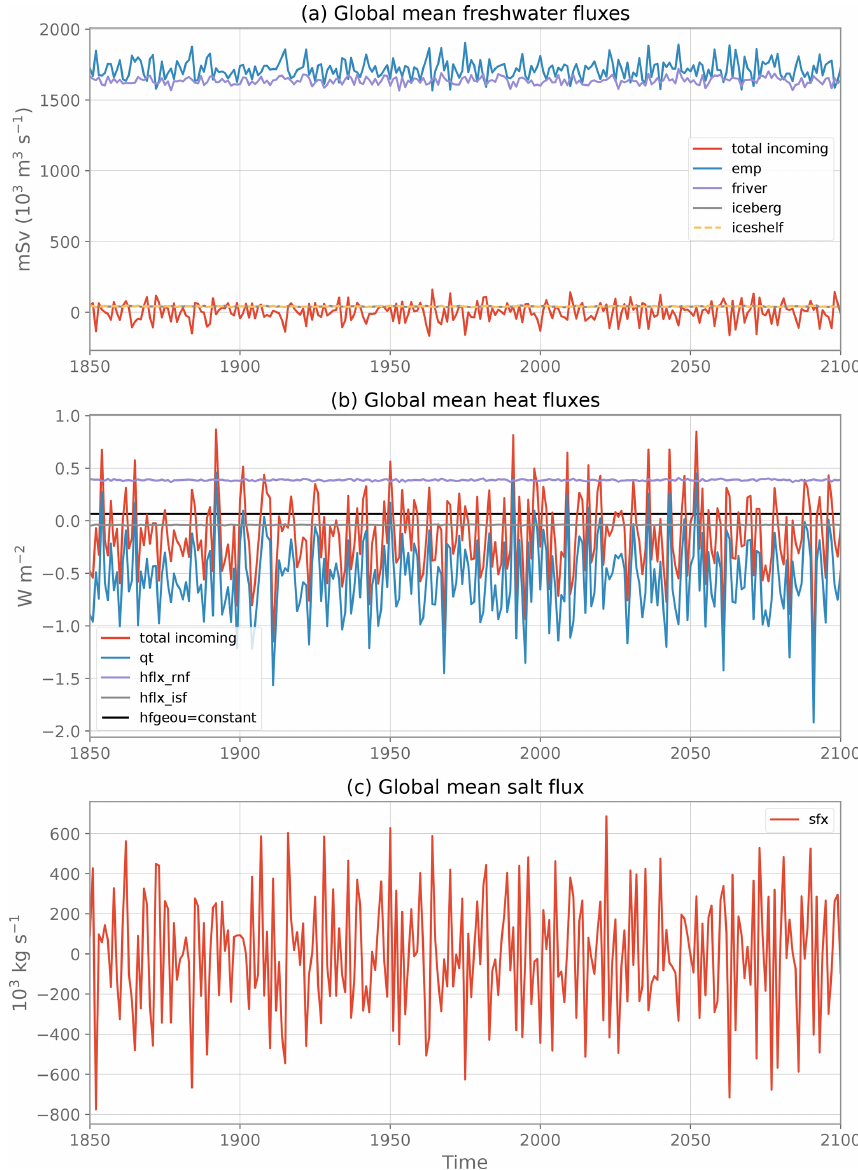
Figure 3. Evolution of the globally averaged, annual mean (a) freshwater fluxes, (b) heat fluxes and (c) salt flux from the piControl and used in CTL. See Table 1 for the signification of each flux